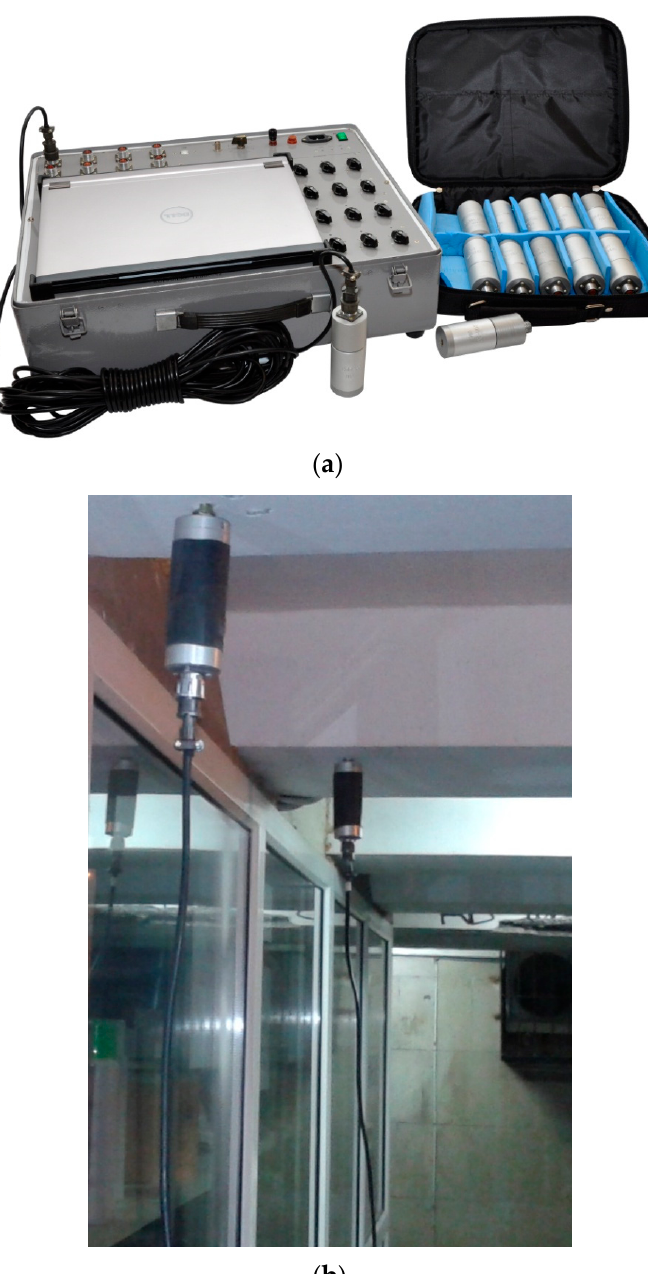
Figure 4. Vibration measuring device ( a ); and scheme of the sensors installation ( b ). Table 1. Main characteristics of the vibration measuring